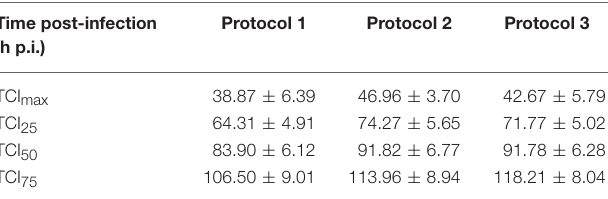
Time post-infection (h p.i.)